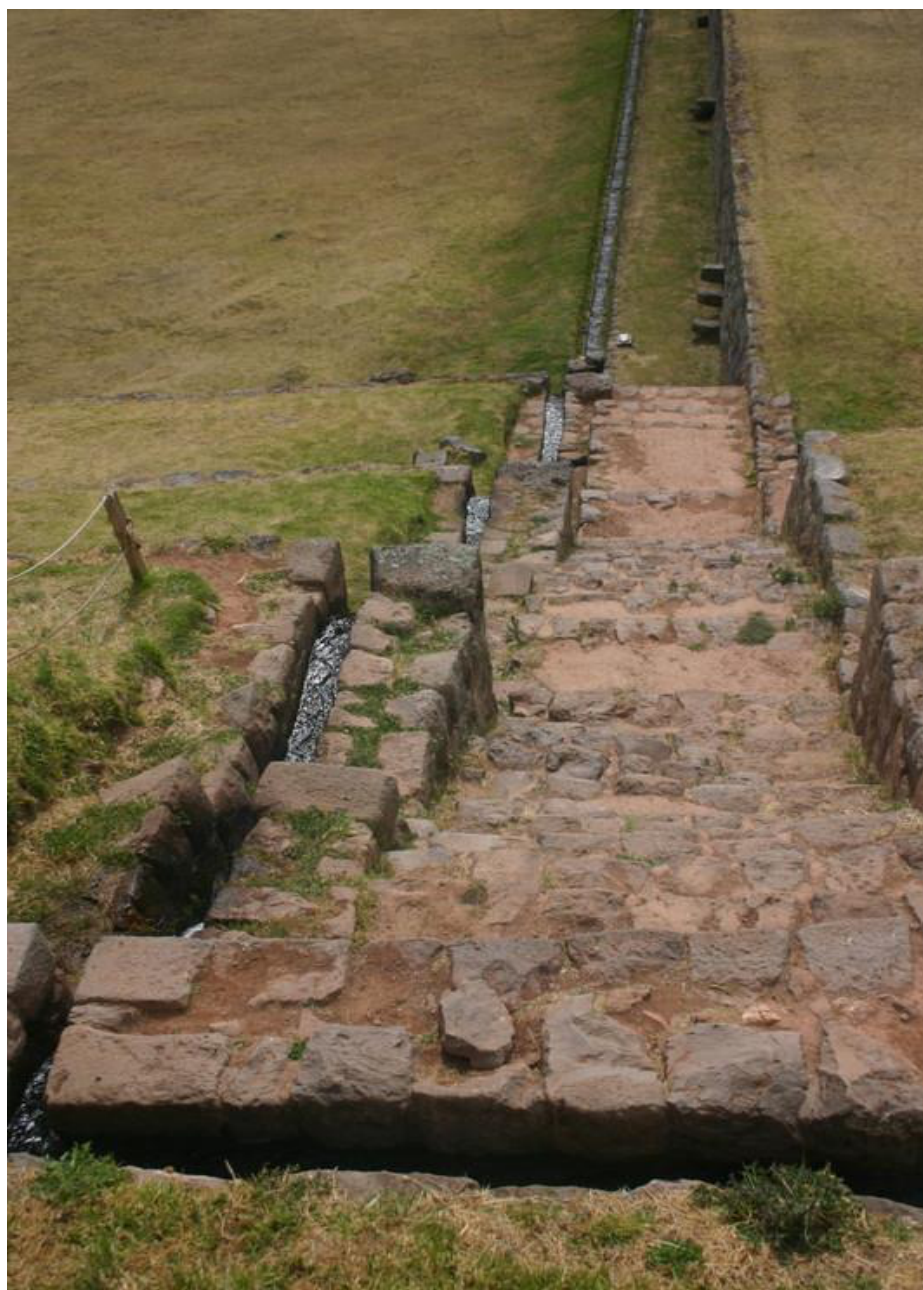
Figure 7. Multilevel side channel collecting individual platform aquifer seepage, excess rainfall runoff and excess water not used for specific purposes directed to lower site levels and the easternmost drainage channel. The figure is associated with the three lowermost platforms shown in Figures 1 and 2. (Photo by C. Ortloff)